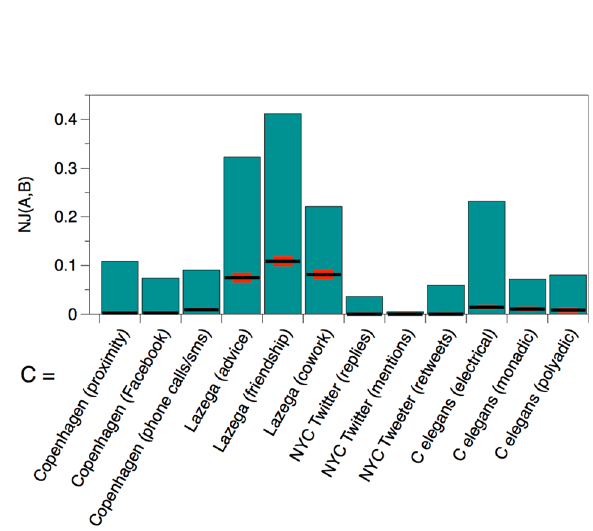
Fig. 5 Similarity between pairs of real-world networks. Values of the network — Jaccard index NJ ð A ; B Þ computed on the four empirical multiplex networks considered, see Table 1 (for each multiplex, we consider the three pair permutations). As a reference, black horizontal lines display NJ null ð A ; B Þ which computes the average over several randomisations of layers A ; B (red lines correspond to ± one standard deviation. We conclude that all pair of layers are genuinely related with the possible exception of the pair NYC Twitter replies vs NYC Twitter retweet.